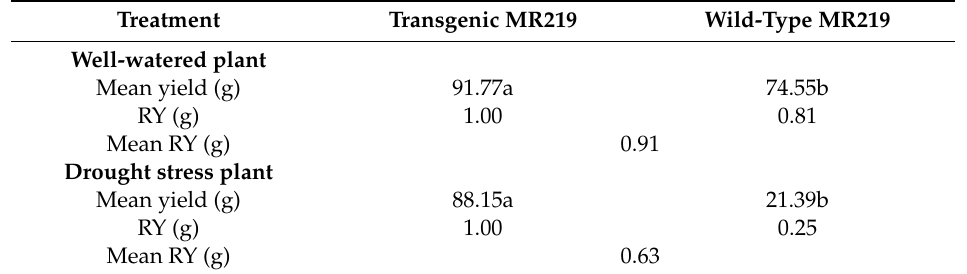
Table 8. The genotypes mean yield, relative yield (RY) performance and mean relative yield of the rice genotypes in response to drought stress treatment.